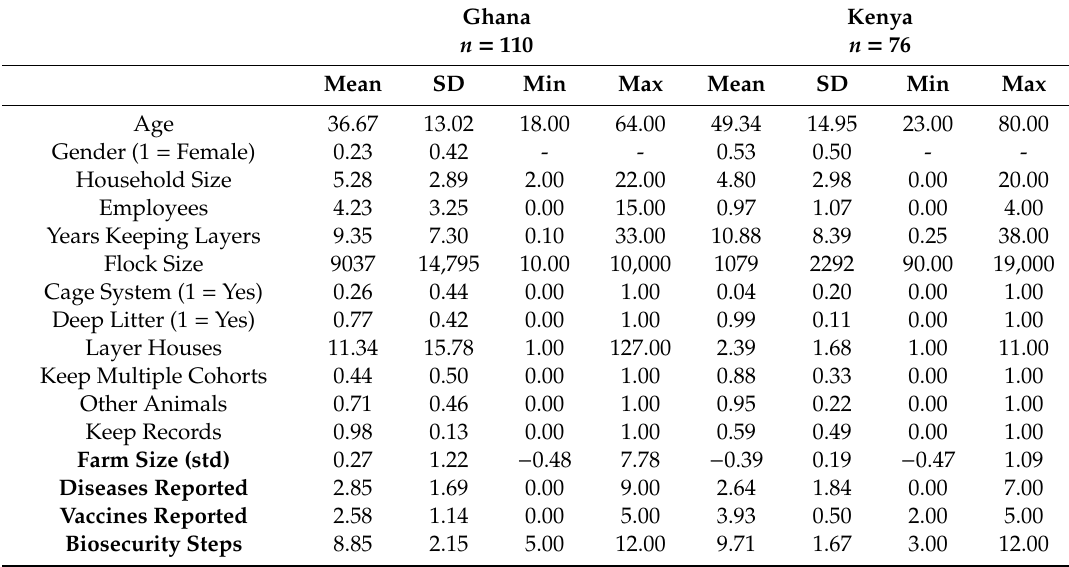
Table 3. Summary statistics across Ghana and Kenya farms. Bolded variables indicate inclusion in models.